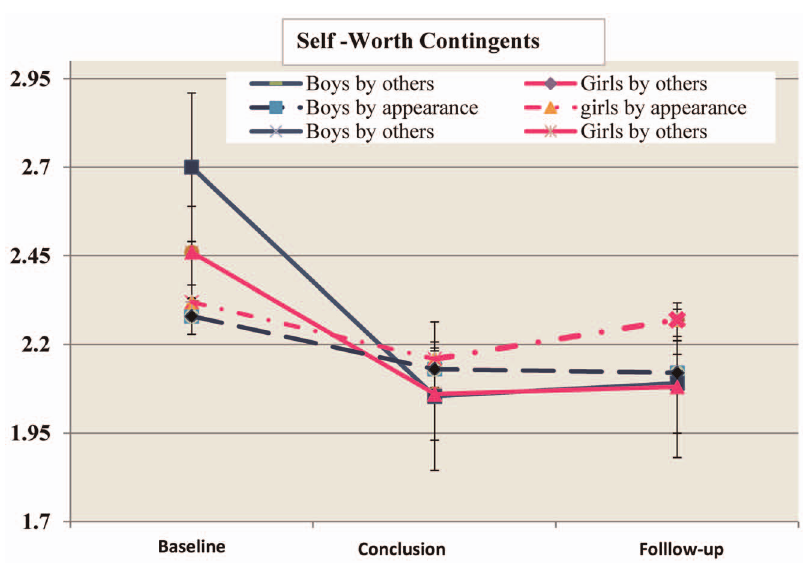
Figure 1. Contingencies of self-worth by others and by appearance (Means ± SD). doi:10.1371/journal.pone.0091778.g001 PLOS ONE |